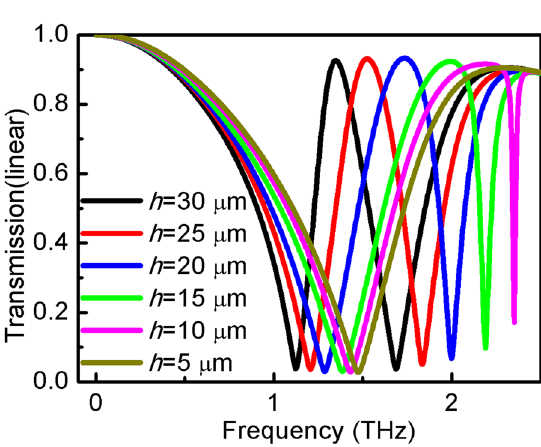
Figure 9. Variation of transmission of the structure at horizontal strip length l 1 .